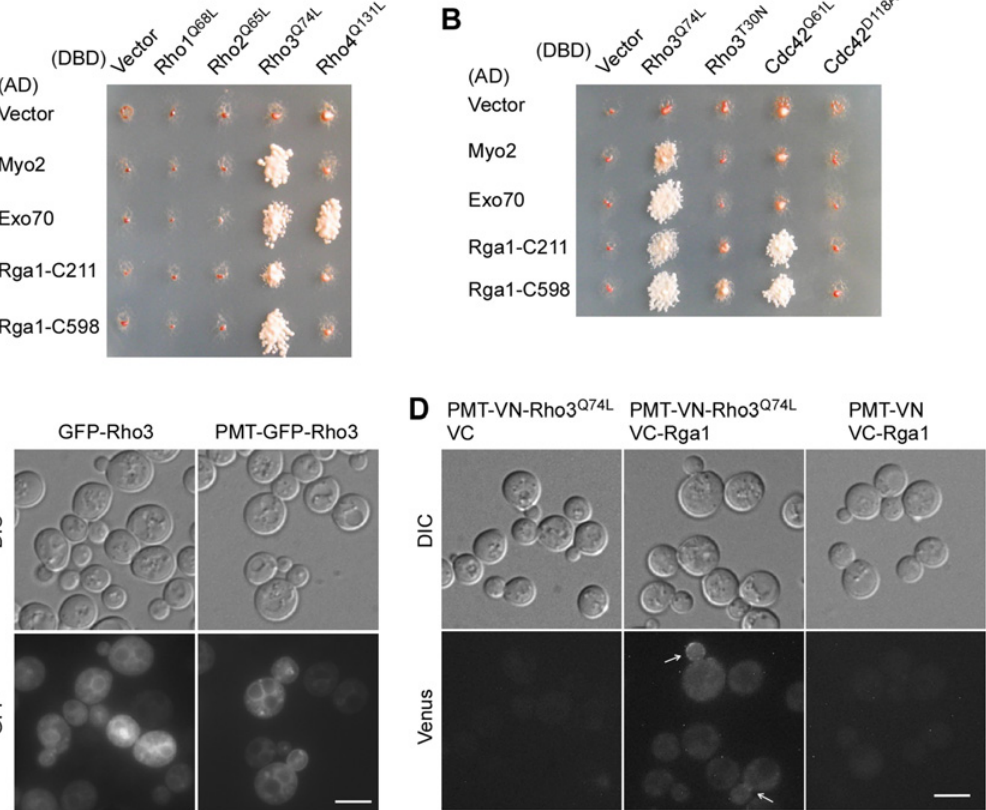
Fig 5. Rga1 interacts with Rho3 in vivo . (A) Two-hybrid assay of the interaction between Rga1 and four Rho GTPases. The assay was performed as described in Materials and Methods . Cells were grown on SC-Leu-Trp-Ade plate. Picture was taken after 4 days at 30°C. Growth indicates interaction between the DBD and AD fusion proteins. (B) Two-hybrid assay of the interaction of Rga1-C211 and Rga1-C598 with Rho3 and Cdc42. Cells were grown on SC-Leu-Ura-Ade plate. Picture was taken after incubation at 30°C for 3 days. (C) GFP-Rho3 and PMT-GFP-Rho3 localization. YEF473A cells carrying pUG36-RHO3 (GFP-Rho3) and pUG36-PMT-RHO3 (PMT-GFP-Rho3) were visualized for GFP fluorescence. (D) BiFC assay between Rga1 and Rho3. Cells of strain JGY2653 ( rho3 Δ ) carrying pVN1-PMT-RHO3 Q74L /pVC1, pVN1-PMT-RHO3 Q74L /pVC1-RGA1, and pVN1/pVC1-RGA1 pairs were grown in SC-Ura-His medium. Green fluorescence was examined by fluorescence microscopy. Bars, 5 μ m.